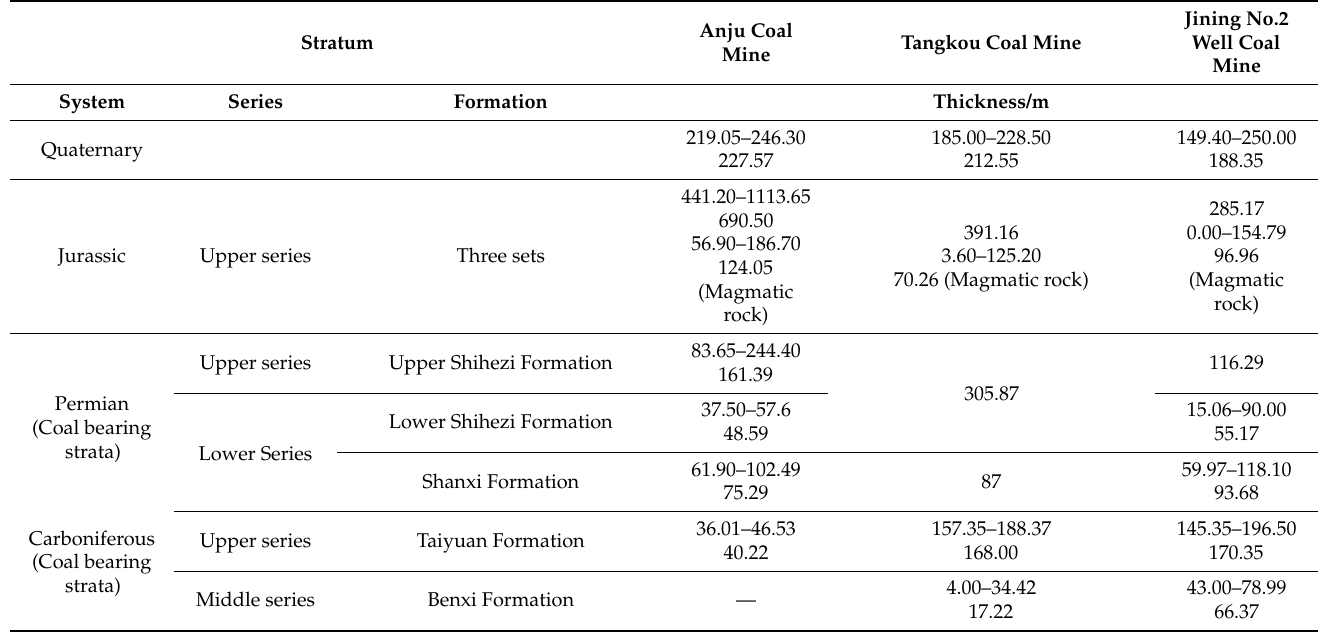
Table 4. Strata distribution of deep mining area in the part of Central-Eastern